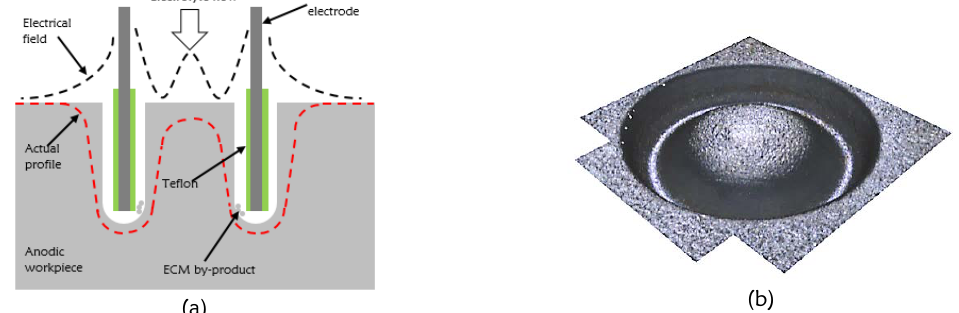
Figure 6: (a) Electrical field around a tubular electrode, and (b) resulted profile of an ECM’ed hole